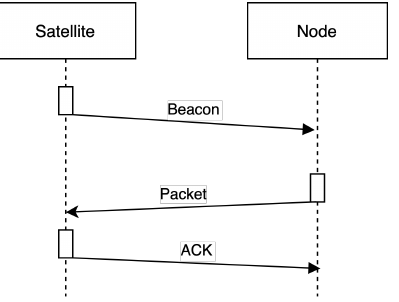
Figure 3. Sequence diagram for random access asyncronised